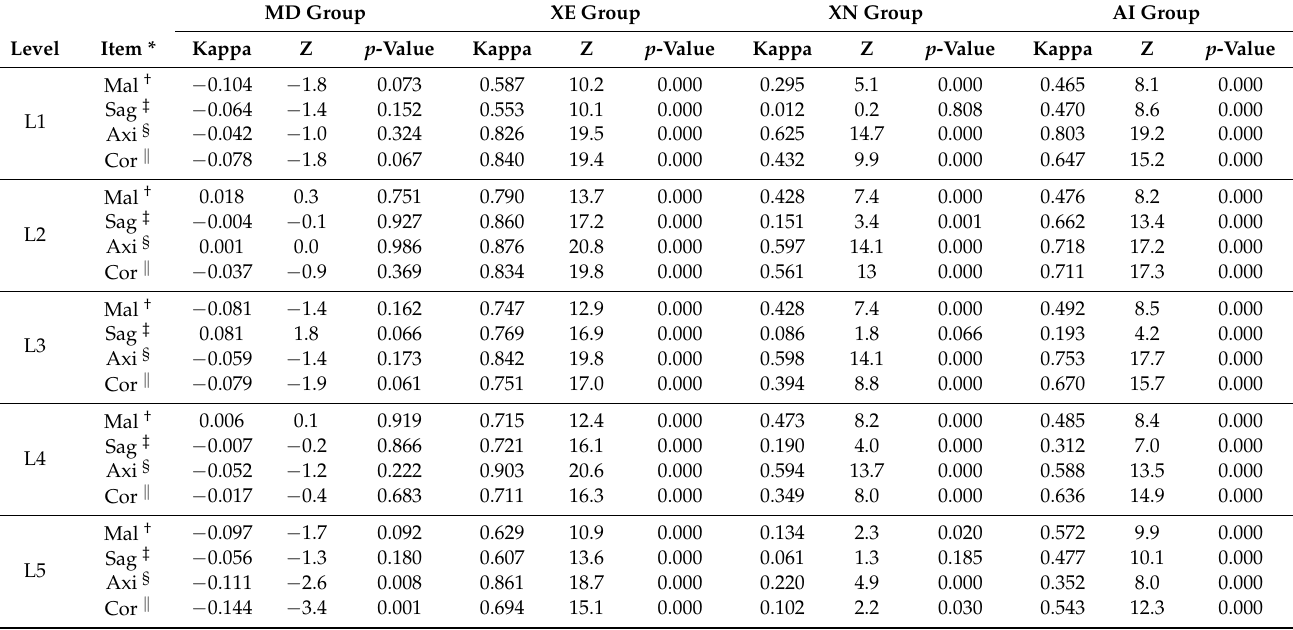
Table 2. Comparison of diagnostic concordance for lumbar spine malposition within diagnostic